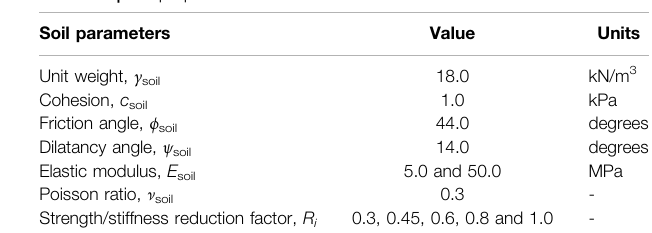
Frontiers in Built Environment |